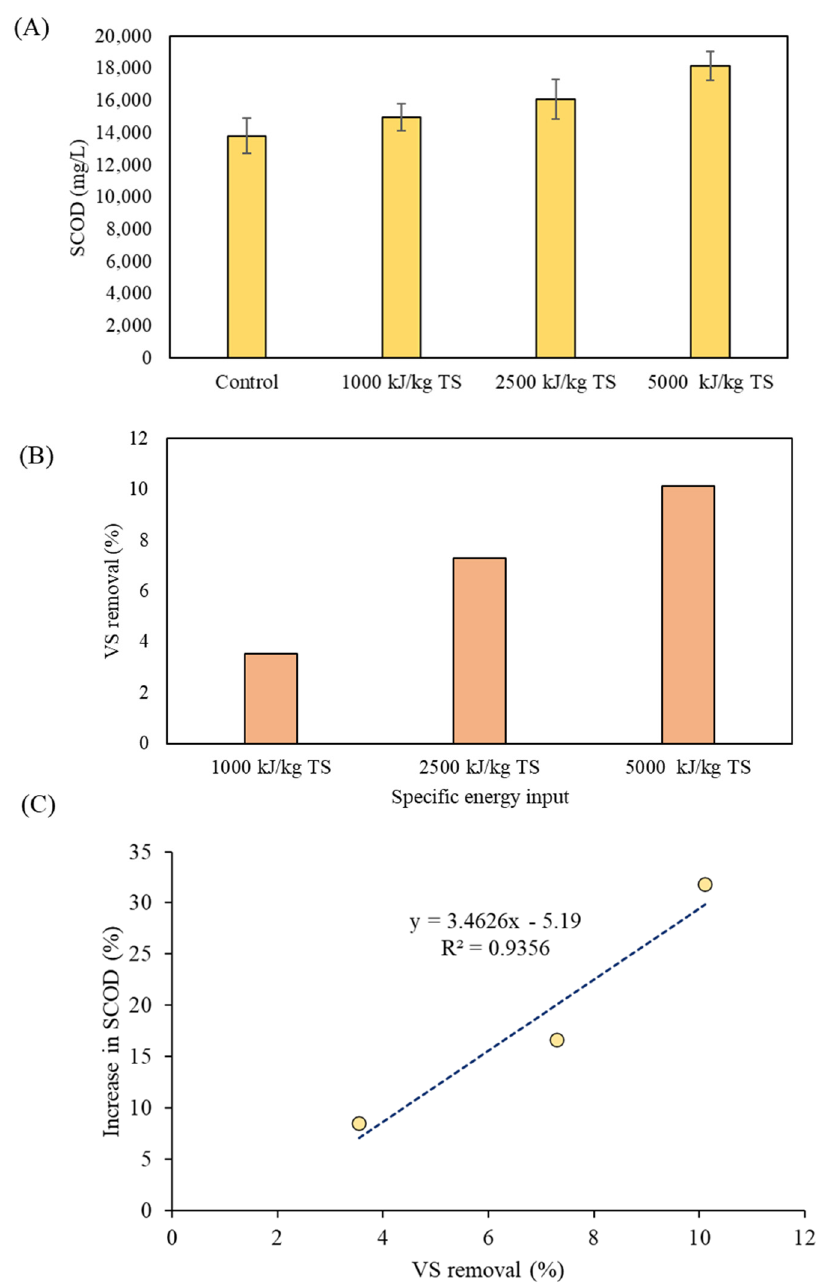
Figure 3. ( A ) Changes in soluble chemical oxygen demand (SCOD) concentrations; ( B ) volatile solids (VS) removal e ffi ciencies; and ( C ) relationship between increase in SCOD concentrations and VS removal e ffi ciencies for di ff erent ultrasonication conditions.